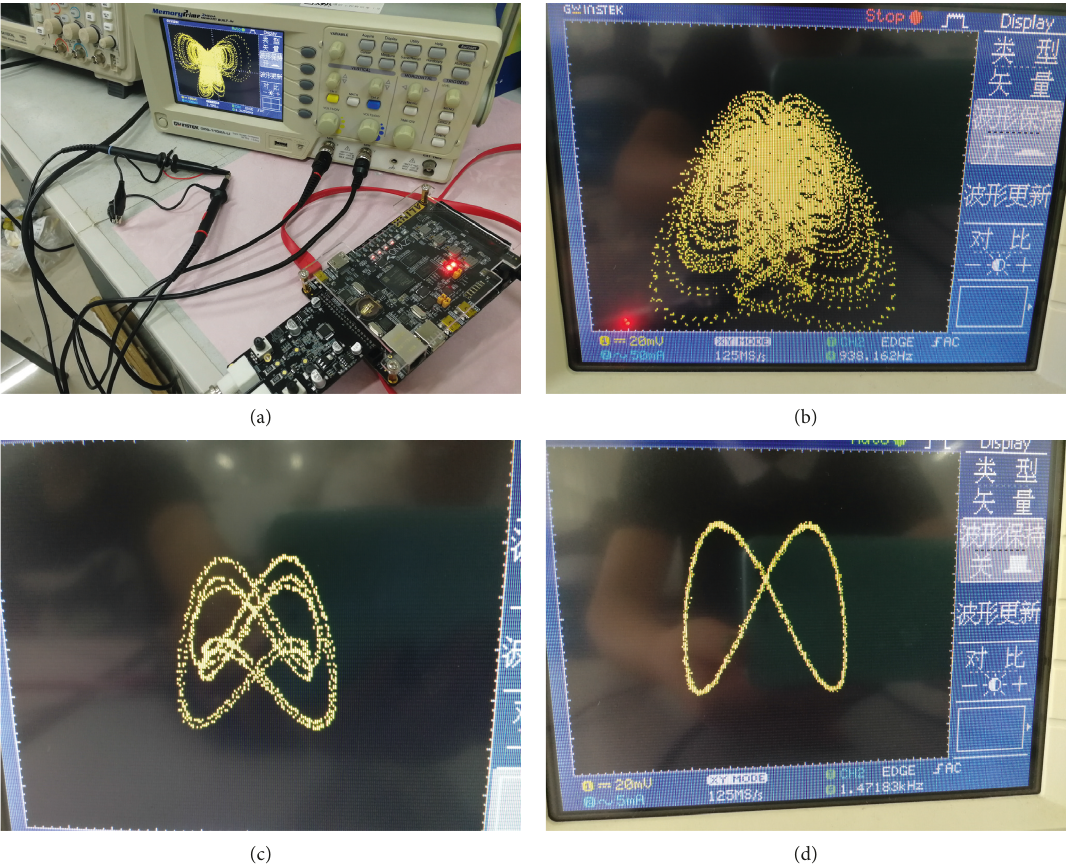
Figure 14: Implementation platform and exemplificative phase portraits generated by the FPGA implementation of the proposed HFWMS: (a) four-wing hyperchaotic attractor, (b) two-wing hyperchaotic attractor, (c) period-5 state, and (d) quasi-periodic